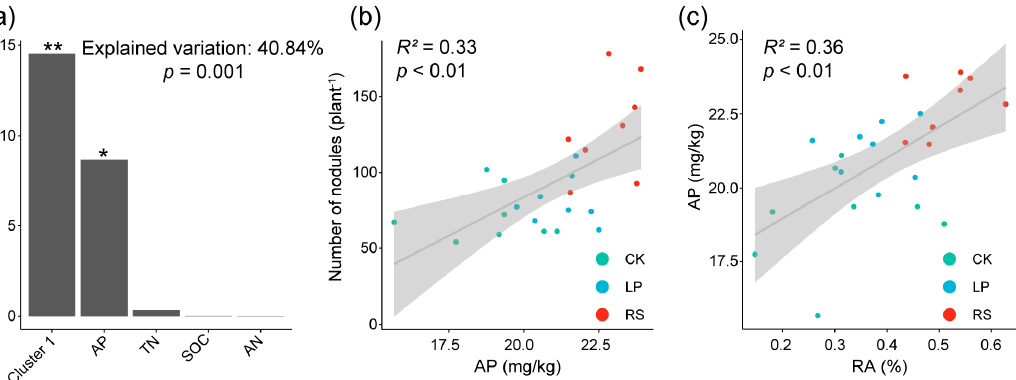
Figure 5. Drivers of peanut nodulation. ( a ) Mean contribution (% of increased mean square error) of relevant variables to peanut nodulation ability based on random forest modeling. The magnitude of the MSE% value implies the importance of the predictors (* p < 0.05; ** p < 0.01). ( b ) The regressions between peanut nodule number and soil AP. ( c ) The regressions between the relative abundance of Cluster 1 and soil AP. Statistical analysis was performed using ordinary least squares linear regressions.